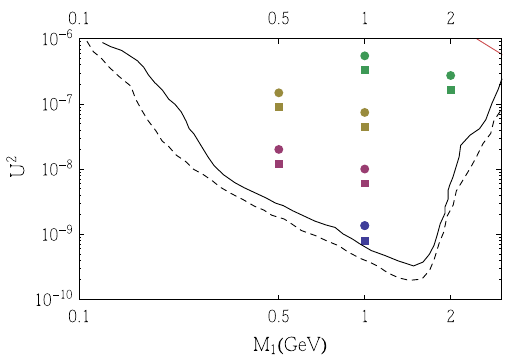
Fig. 1 Lines corresponding to two expected events for scenarios II ( solid ) and IV ( dashed ) in [13]. The indicated points correspond to the CPconservingcaseand γ = 2 , 3 , 4 , 5inascendingorderforIH( circles ) and NH ( squares ). The red line in the top right corner corresponds to one-loop corrections to neutrino masses being of the same order as the atmospheric splitting for (cid:9) M / M 1 =